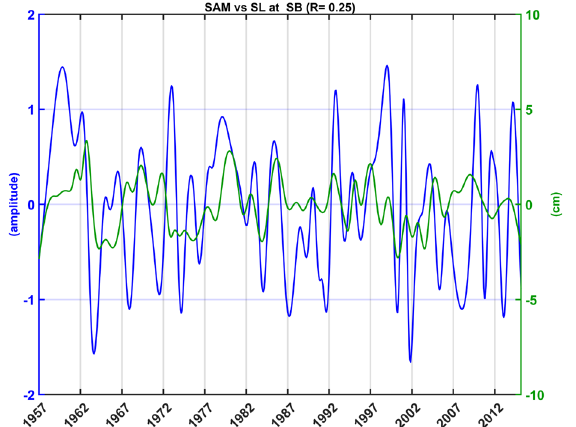
Figure 8. Time series of interannual Southern Annular Mode (SAM; [34], 2003) and SL records at Simons Bay. Blue and green colours indicate the SAM and SL (in centimeters), respectively. The correlation coefficient is found in the panel title.